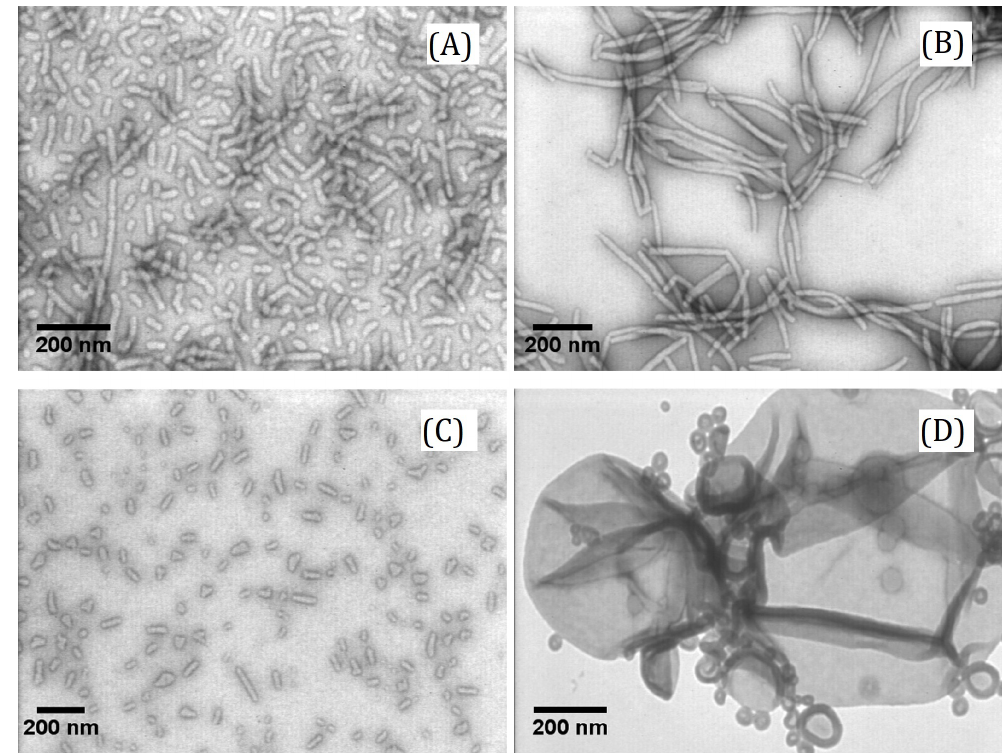
Figure 10. TEM micrographs of self-assemblies of ( A – C ) PMAChol-bPDEAAm at different degrees of polymerisation (DP) of the hydrophilic block. ( A ) DP = 103, ( B ) = 30, ( C ) = 21. ( D ) PS 136 -b-PDEAAm 32 . Reprinted with permission from Boissé et al., Macromolecules 2009, 42, 22, 8688–8696